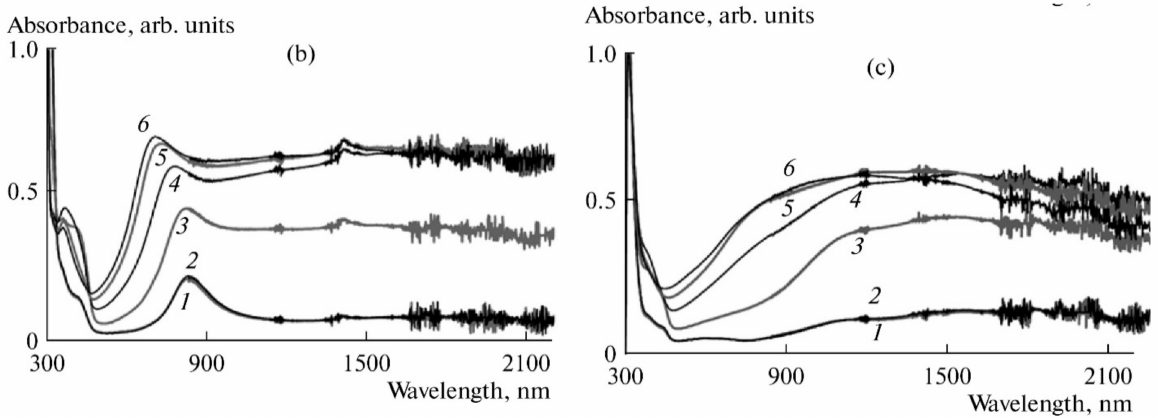
Figure 1. Evolution of in situ UV–Vis–NIR spectra of PANI films prepared by electrochemical polymerization in the presence of flexible-chain PAMPSA ( b ) and rigid-chain t-PASA ( c ) polyacids with potential, V: 0.0(1), 0.2(2), 0.4(3), 0.6(4), 0.8(5), and 0.9(6). Electrolyte: 0.1 M HClO 4 and 0.9 M NaClO 4 in acetonitrile. Reprinted by permission of Springer Nature Customer Service Centre GmbH: Springer Nature, Russian Journal of Electrochemistry, “The spectroelectrochemical behavior of films of polyaniline interpolymer complexes in the near infrared spectral region”, A. A. Nekrasov et al., Copyright 2012